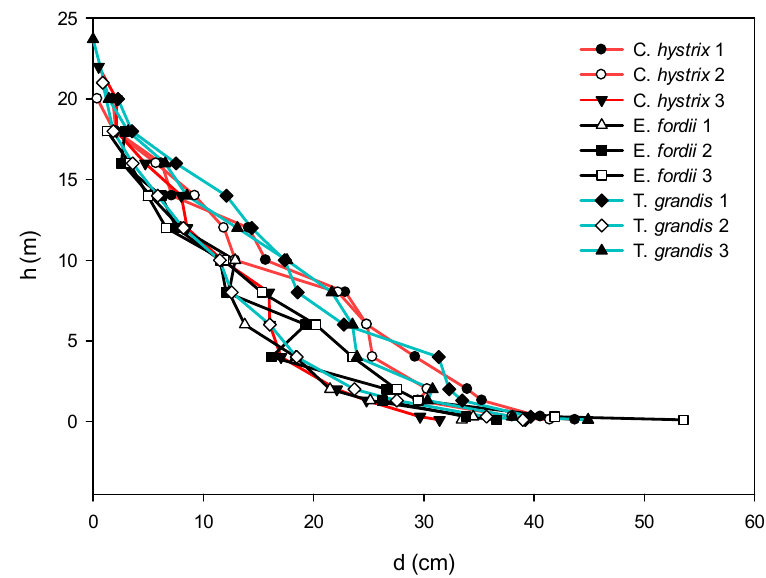
Figure 2. Observed height (h) above the ground-outside bark diameter (d) curves for nine dominant or codominant trees.